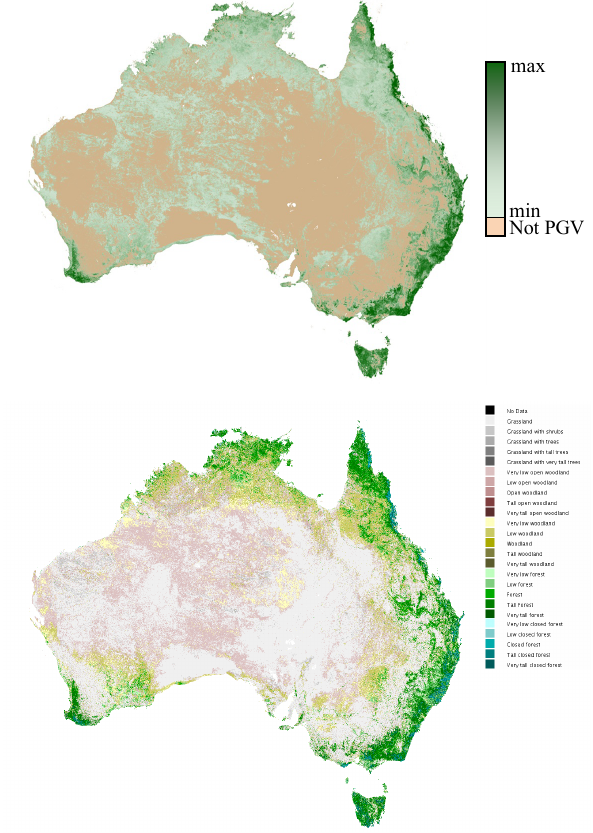
Figure 6. Vegetation persistent green vegetation cover (top) and structural formation (bottom) maps for Australia. The structural formation map was generated from integration of the Landsat persistent green vegetation cover, ALOS PALSAR, and ICESat GLAS satellite